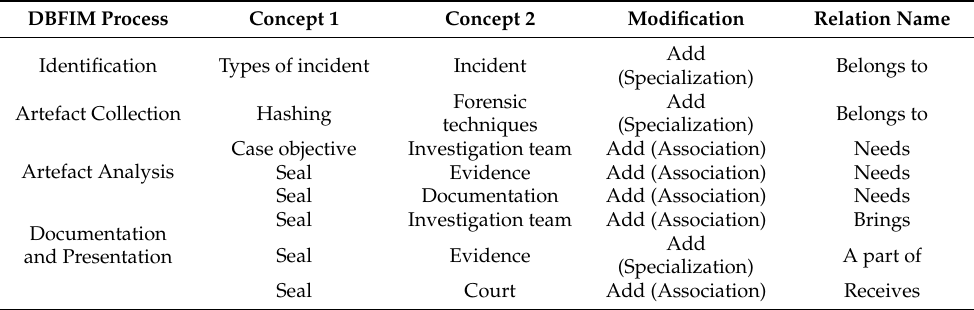
Table 3. Three new added concepts based on face